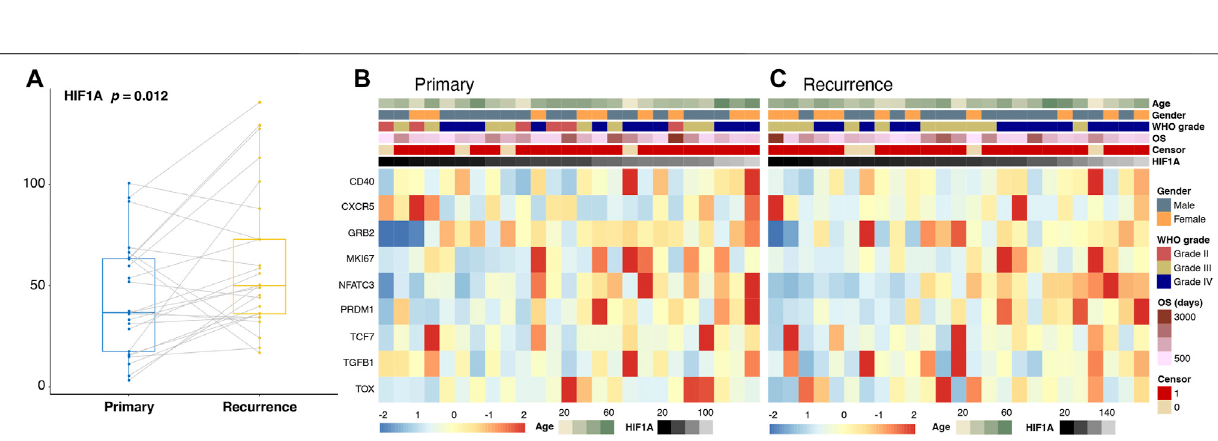
Frontiers in Pharmacology |